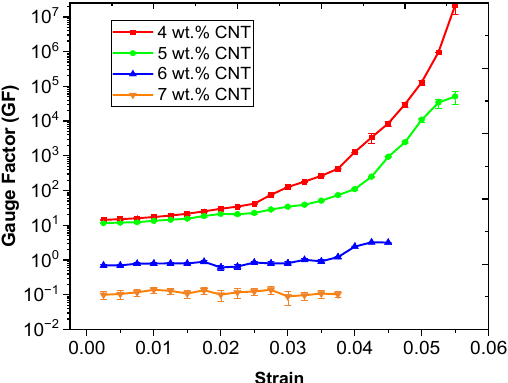
Figure 6. Gauge factor value of CNT–Surlyn nanocomposites as function of applied strain.